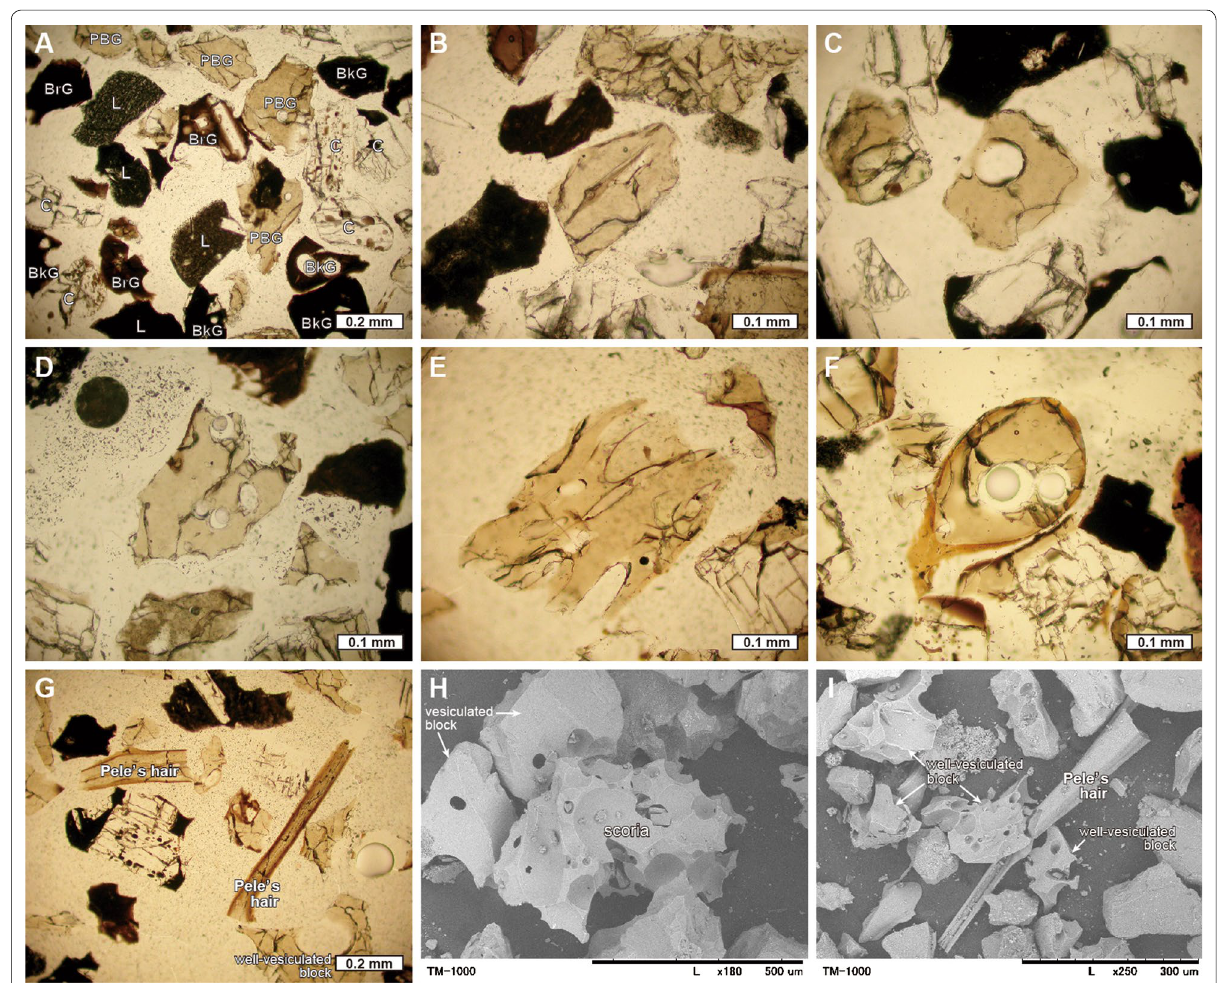
Fig. 6 Polarizing microscope photographs ( A – G ) and secondary electron micrographs ( H – I ) of glass shards included in the 2014–2015 ash-fall deposits. A Glass shards and lithic grains in the December 9–11, 2014 ash. BkG: black glass, BrG: brown glass, C: crystal, L: lithic, PBG: pale